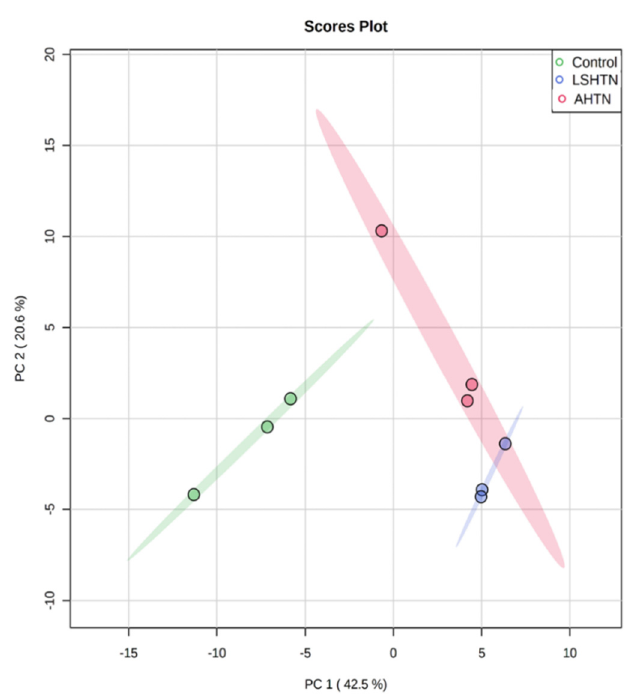
Figure 2. Metabolomics data of serum showing segregation of hypertensive groups from control. Principal components analysis (PCA) plot of metabolites present in the serum based on untargeted metabolomics demonstrated visible segregation based on peak intensity values of metabolites in both LSHTN and AHTN mice when compared to control mice, ( n = 3).